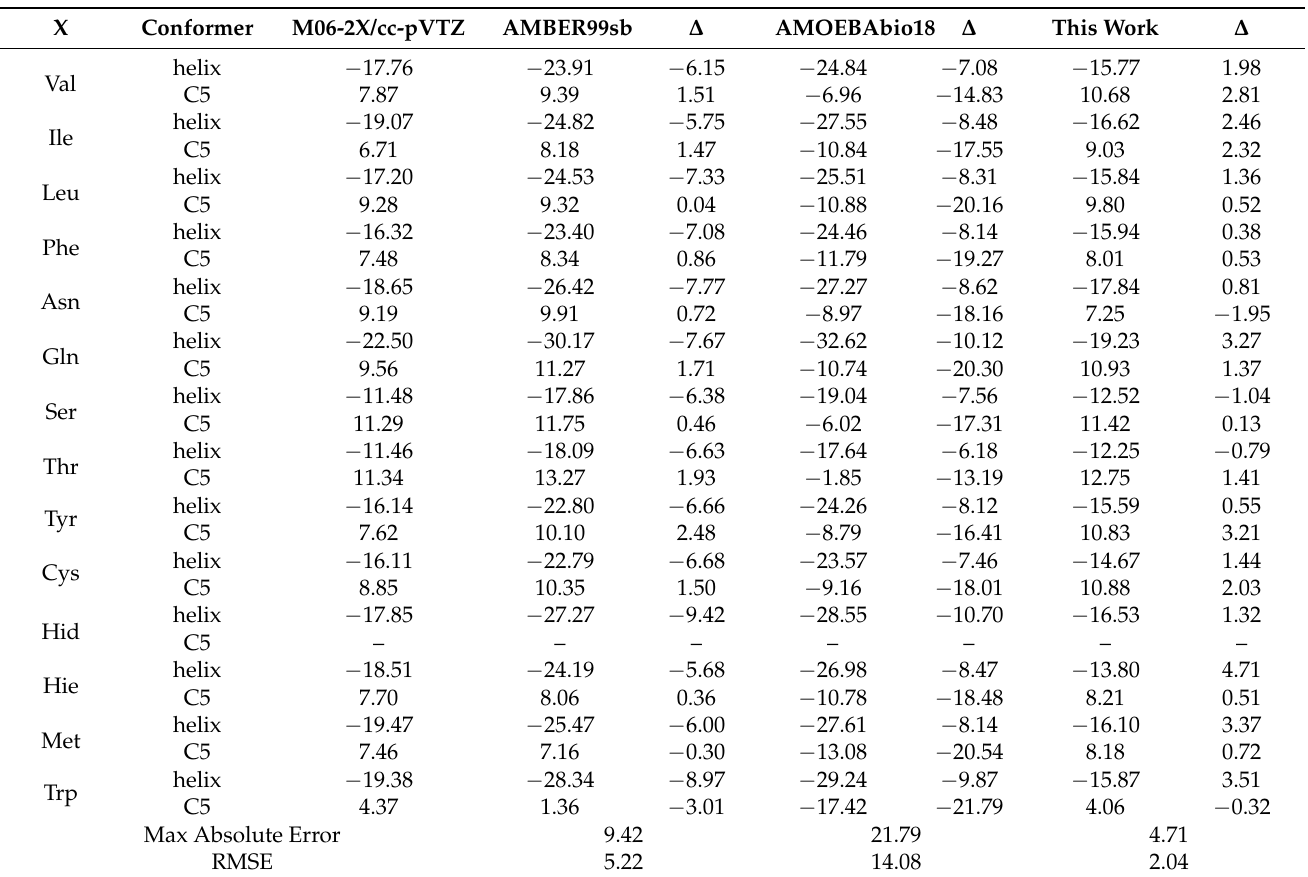
Table 2. Conformational energies (kcal/mol) relative to the C7 eq conformer for AcAla 4 XAla 4